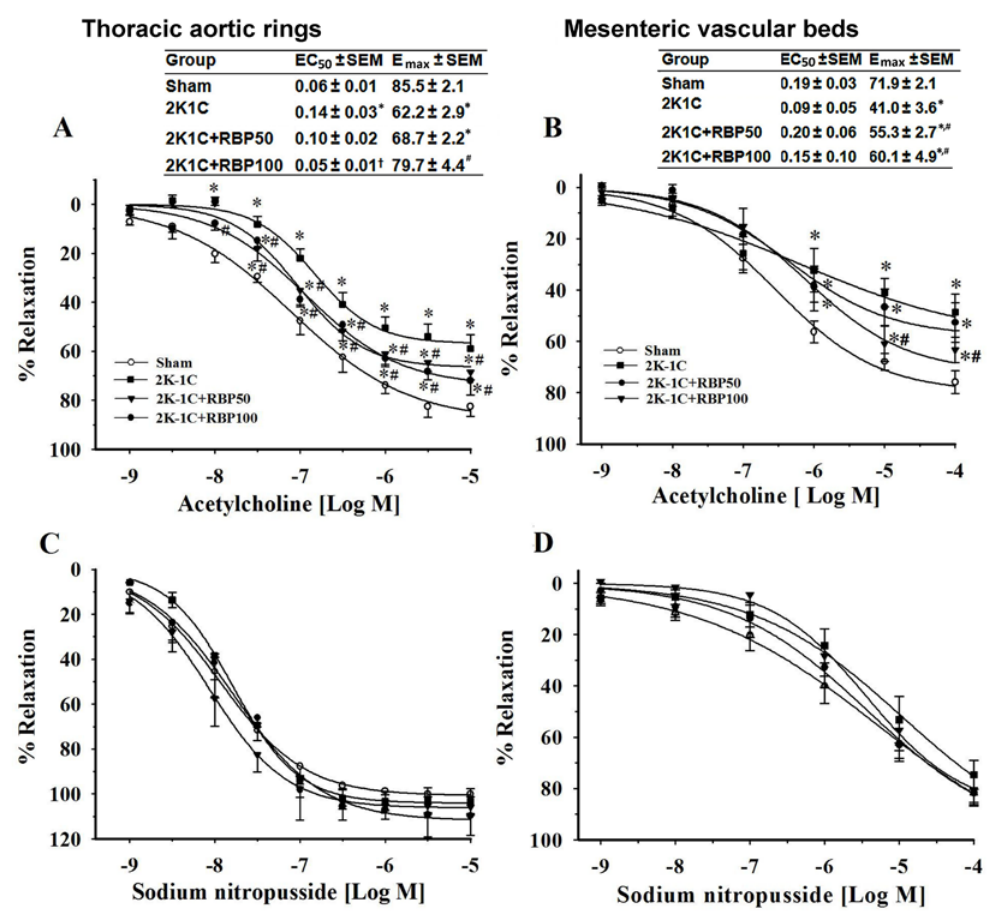
Figure 1. Effect of RBP on endothelium-dependent vasorelaxation induced by acetylcholine and endothelium-independent vasorelaxation induced by sodium nitroprussside in aortic rings pre-contracted with phenylephrine ( A , C ) and mesenteric artery beds pre-contracted with methoxamine ( B , D ). Data are mean values ± SEM; ( n = 8/group), * p < 0.05 vs. sham-operated group, # p < 0.05 vs. 2K-1C group; Rice bran peptides, RBP; Maximal response, E max ; half maximal effective concentration, EC 50 .